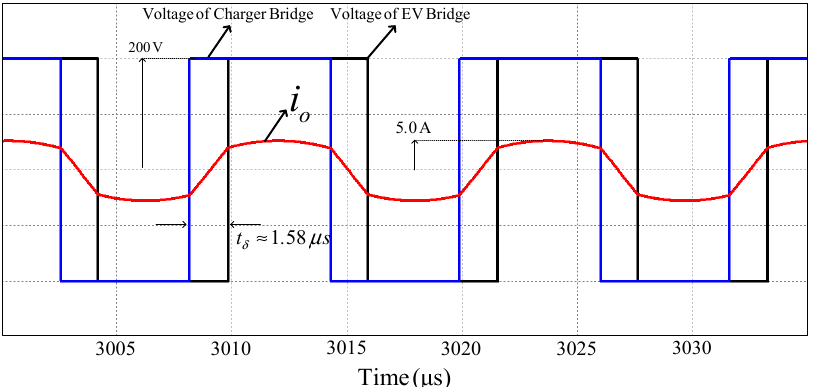
Figure 6. Output voltage of charger bridge, EV bridge and i o under equal voltages condition with τ 1 = 2 µs and τ 2 = 1 µs.